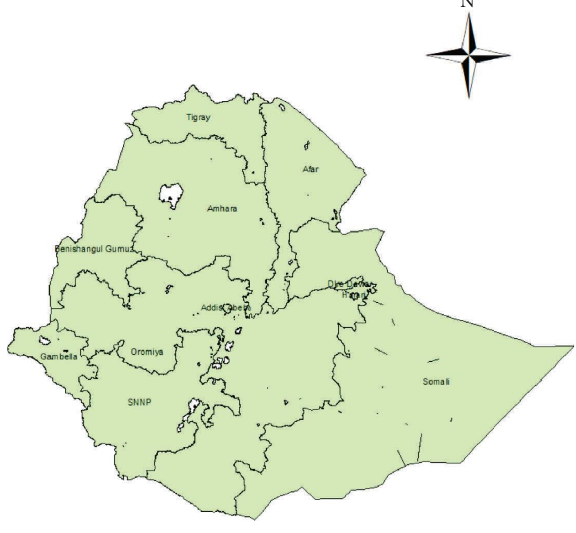
Figure 1: Map of Ethiopia with its nine regions and two city